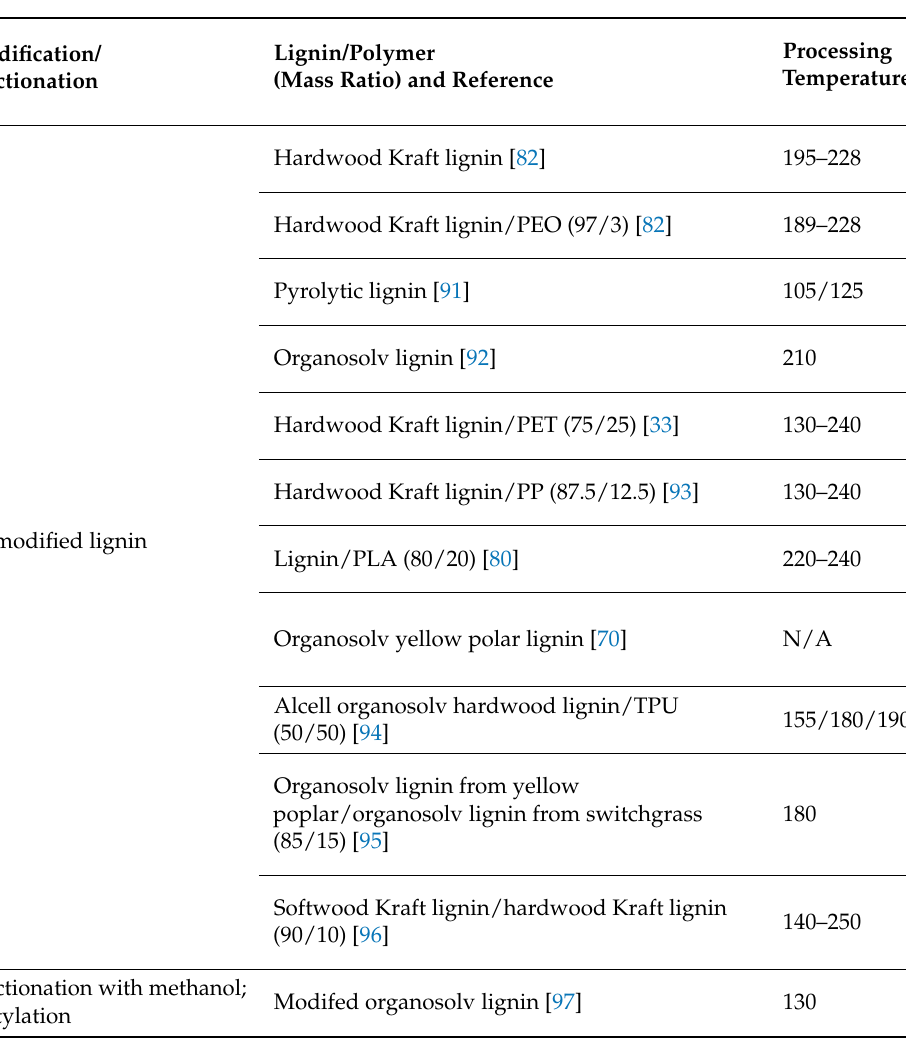
Table 1. Literature summary of melt-spun lignin-based carbon